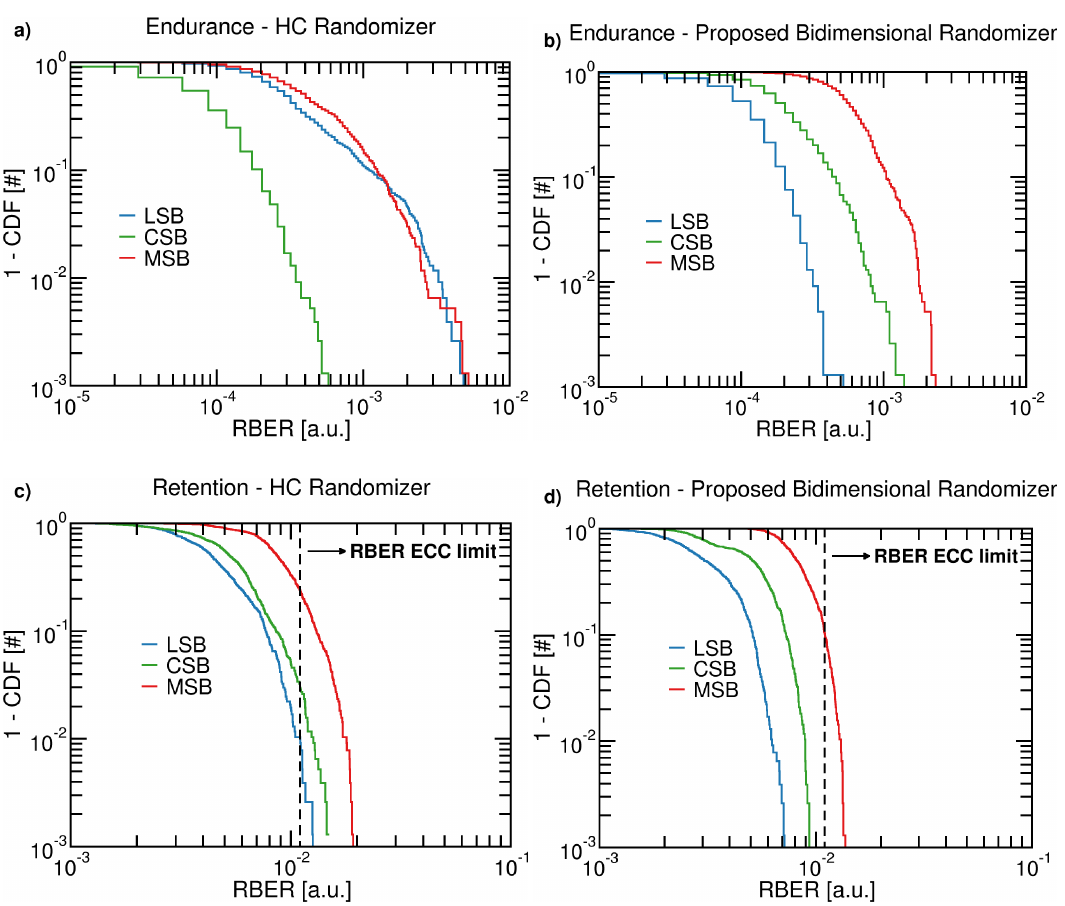
Figure 10. Complementary Cumulative Distribution Function (1-CDF) of the RBER in a 3D NAND Flash memory for Endurance and Retention working corners when the input data come from an HC randomizer ( a – c ) or from our proposed method ( b – d